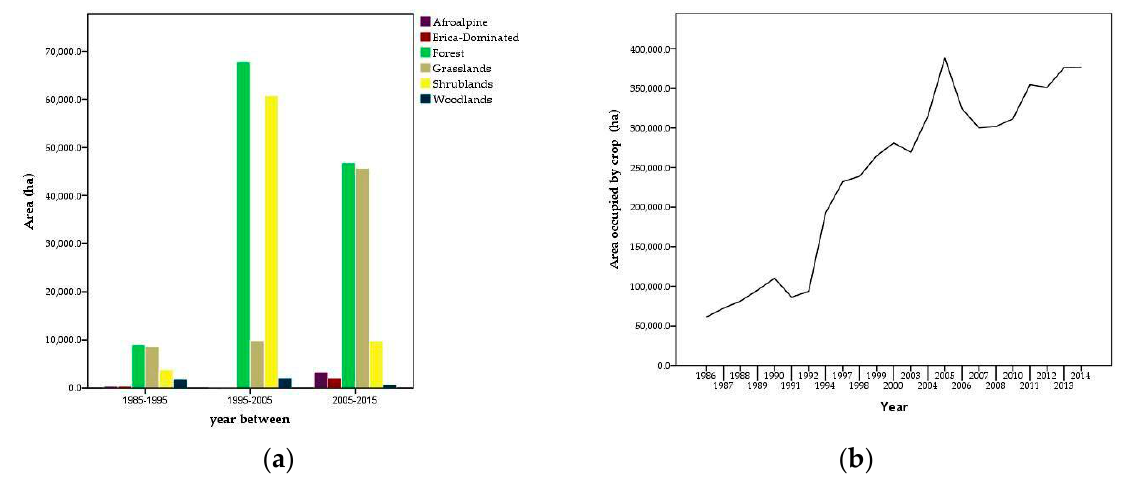
Figure 6. LULC types changed to farmland ( a ) in BMER and area occupied by crops in Bale Zone ( b